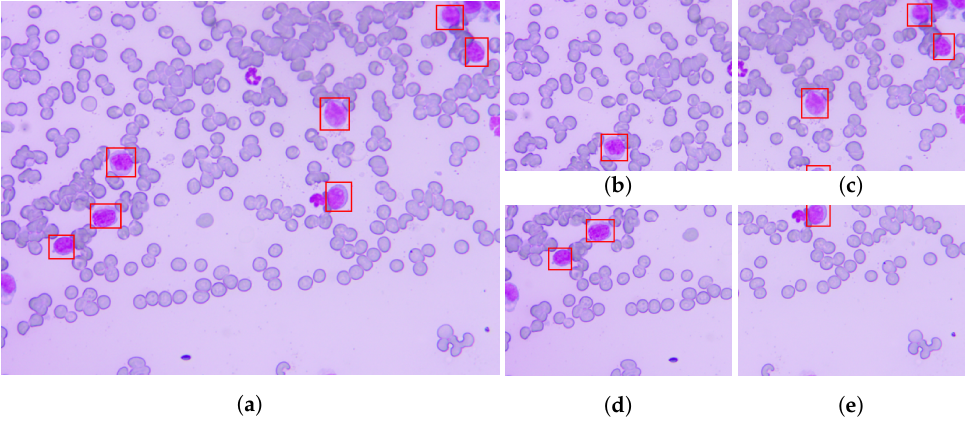
Figure 6. Image split for ’divided’ dataset. ( a ) Original photo from the initial set with labels applied. ( b ) Discarded fragment. ( c ) Used fragment. ( d ) Used fragment. ( e ) Discarded